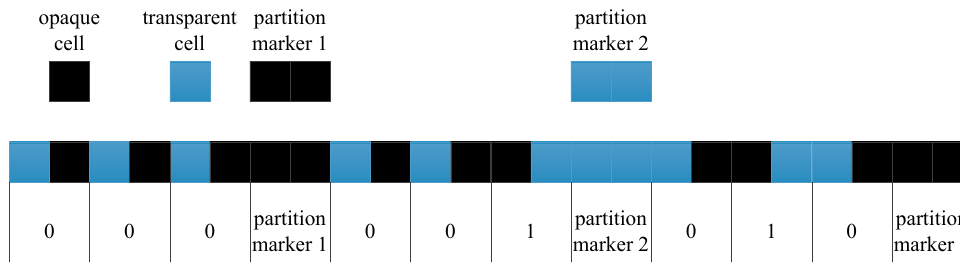
Figure 2. Encoding method of absolute position.